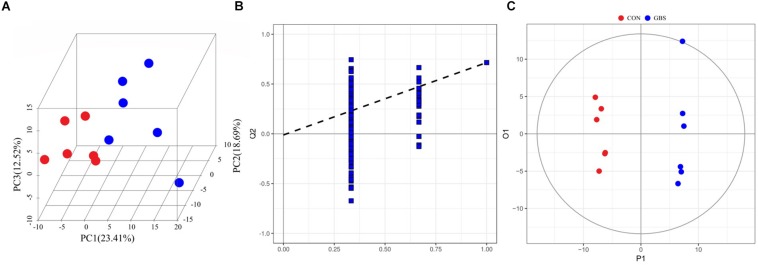
3D PCA score map (A), corresponding PLS-DA validation plots (B), and OPLS-DA score plots (C) derived from the GC-TOFMS metabolite profiles of milk from the control group (green circles) compared to the S. agalactiae group (blue circles).